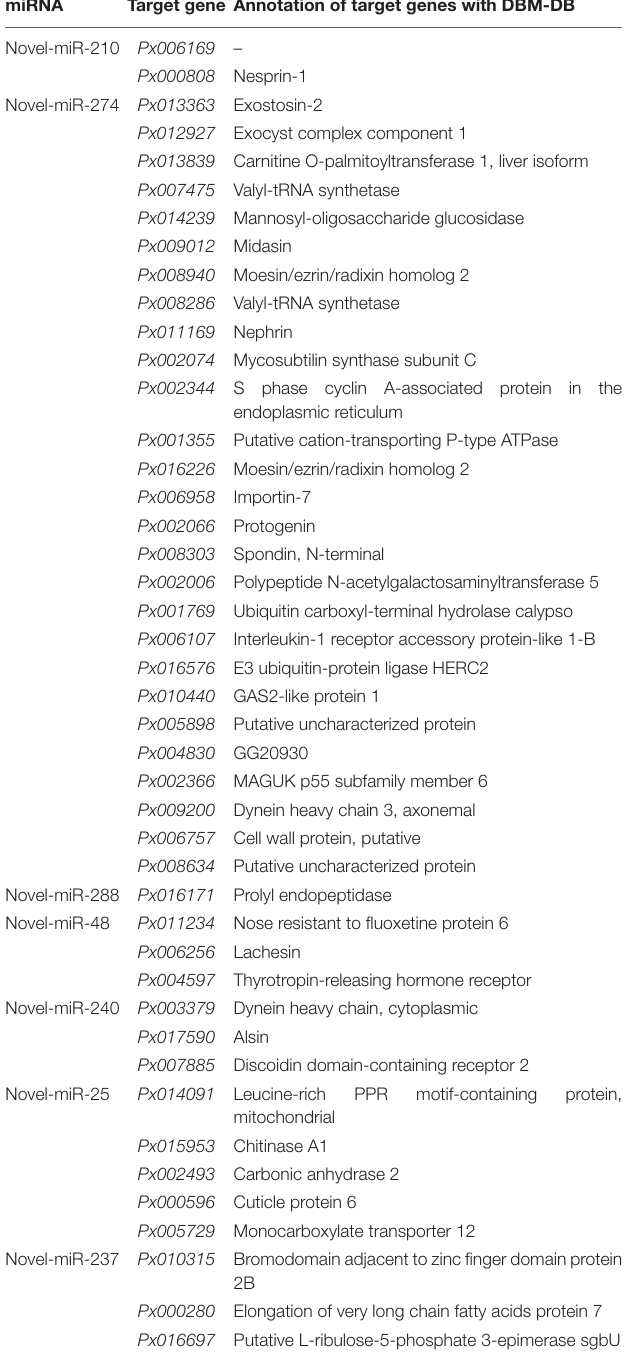
TABLE 3 | Putative target genes of differentially expressed novel miRNAs. miRNA Target gene Annotation of target genes with DBM-DB Novel-miR-210 Px006169